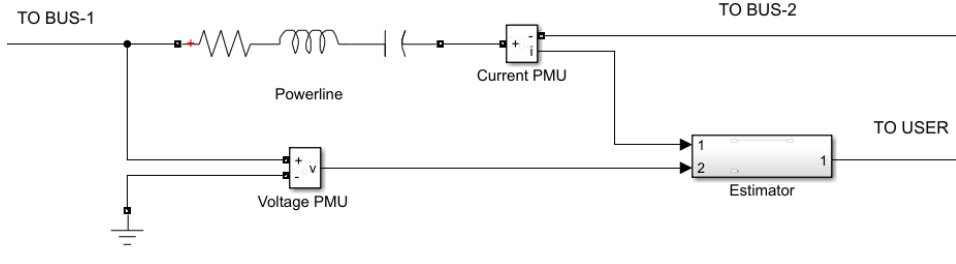
Figure 3. Diagram of the proposed configuration.